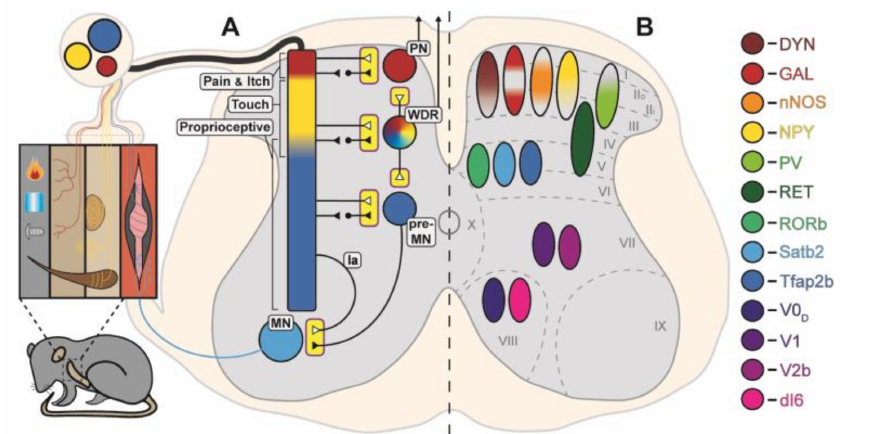
Figure 1. Organization and points of control within sensorimotor pathways. ( A ) Cutaneous and proprioceptive receptors responding to a diverse array of sensory signals terminate in various, and often overlapping, laminae of the spinal cord. Projection neurons (PN) and motor neurons (MN) are the major output neurons of the spinal cord and wide dynamic range (WDR) and pre-motor neurons (pre-MN) neurons play an integrative role in sensorimotor pathways. All of these neurons receive direct (white triangles) and indirect (black triangles) afferent input and are subject to pre- and postsynaptic inhibition (yellow boxes). ( B ) Schematic representation of inhibitory populations involved in afferent gating. Inhibitory interneurons in the superficial dorsal horn are neurochemically subdivided into largely non-overlapping subpopulations, with the exception of dynorphin (DYN) and galanin (GAL) which are highly co-expressed. Molecular markers subdivide inhibitory populations in the deep dorsal and ventral horns. Ovals denote predominant laminar distribution but do not necessarily reflect medial-lateral positioning. Shading within ovals represents the regions of highest density for individual